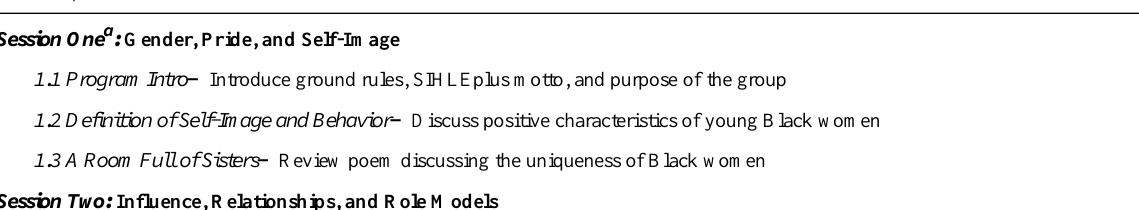
Table 1. Table of contents for the SIHLEplus manual. Modules, activities Session One a : Gender, Pride, and